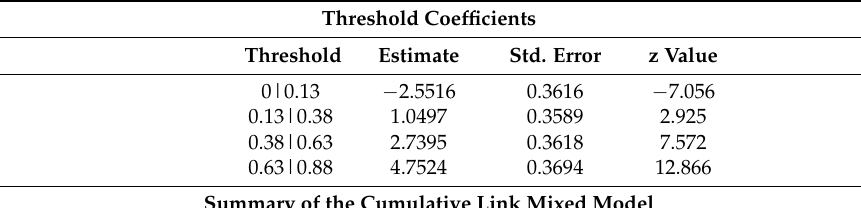
Table 5. Threshold coefficients and summary of the cumulative link mixed model predicting ericaceous shrub percent cover as a function of harvesting and biophysical